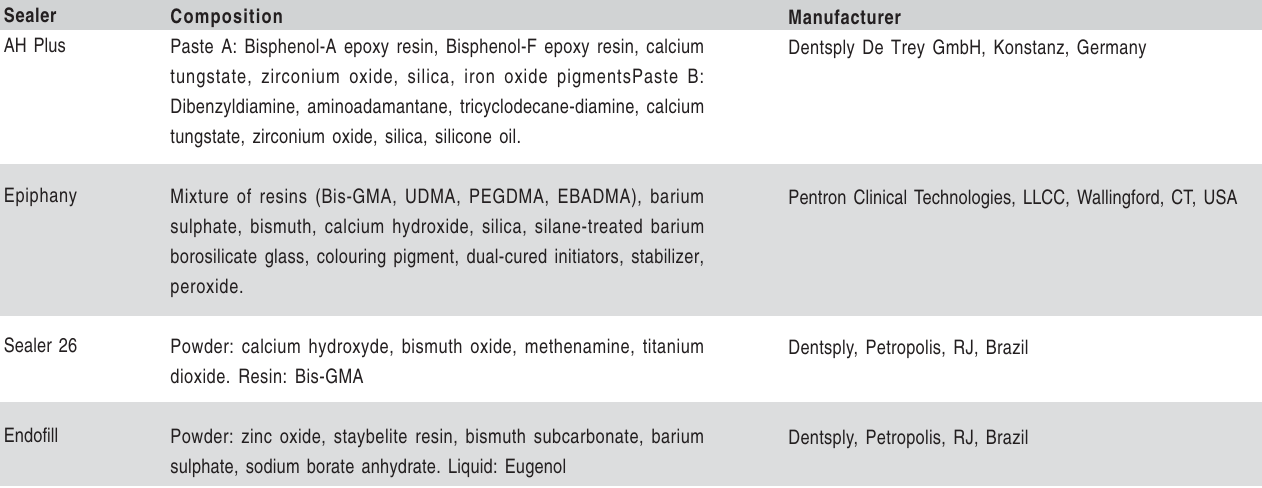
Table1. Main composition of evaluated